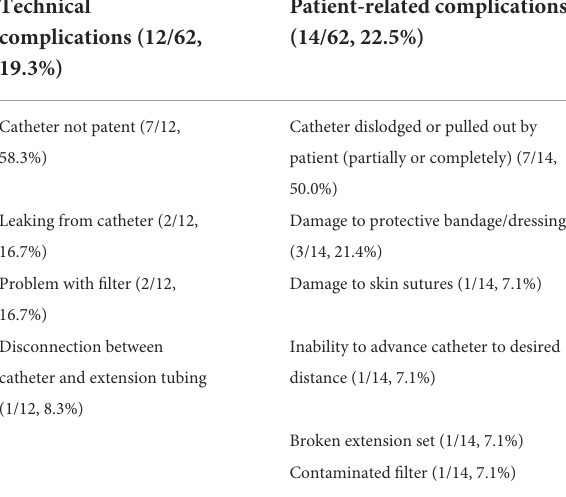
TABLE 1 Technical and patient-related complications observed in 62 epidural catheters ( n , percentage).